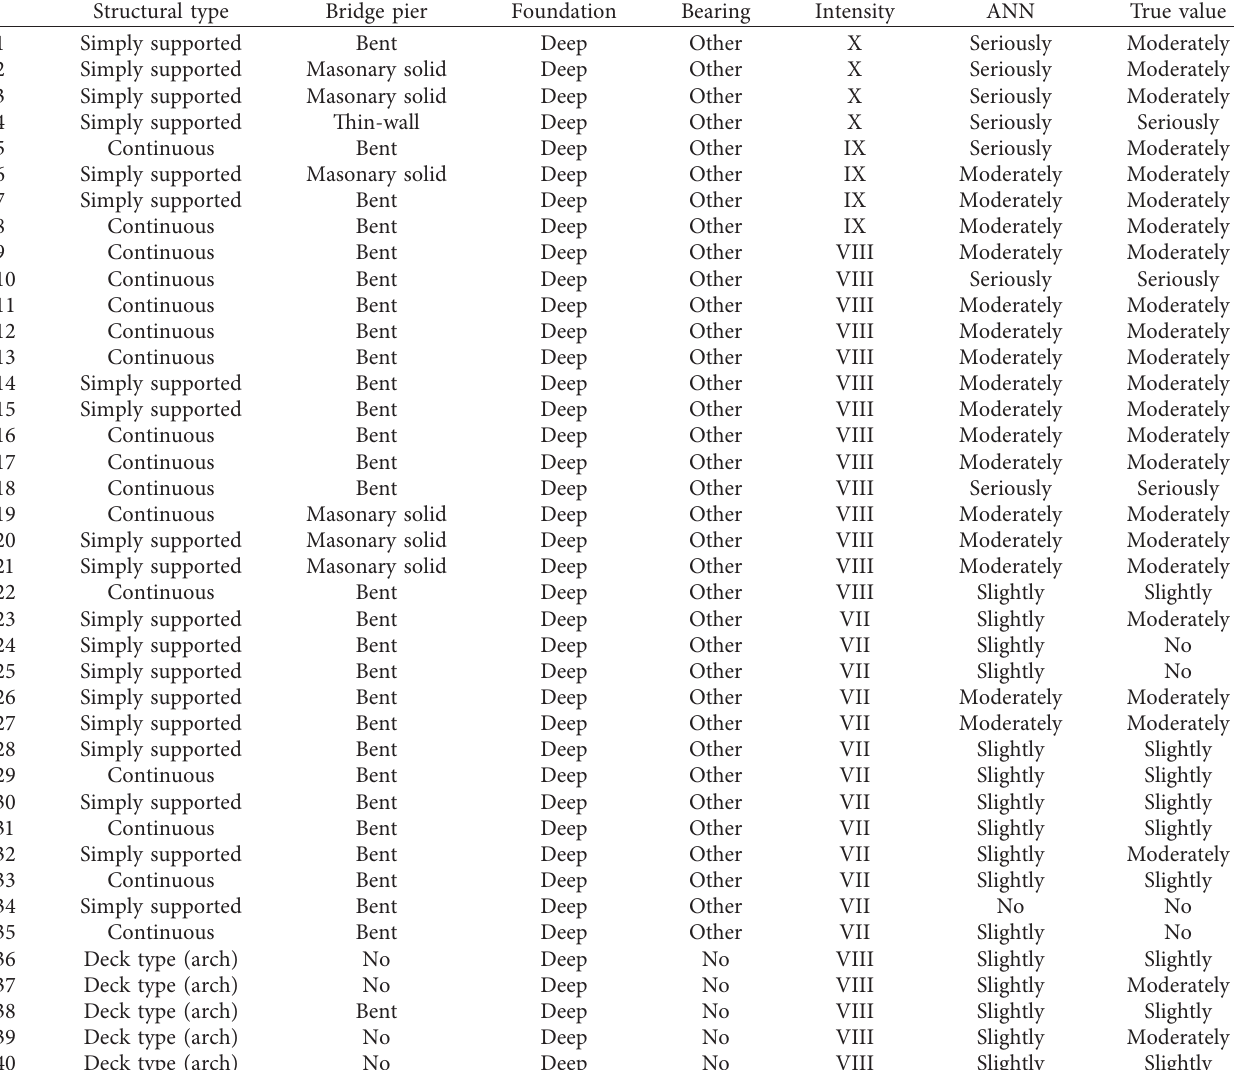
Table 7: The data of the 40 bridges and the comparison of the true value and prediction results by the ANN model for the Tangshan earthquake in 1976 (the arch bridges are specially marked and the girder bridges are not marked. “Intensity” means the practical intensity). Structural